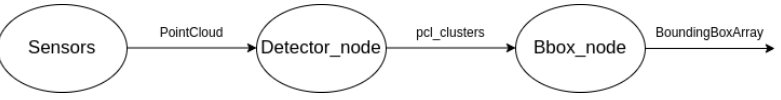
Figure 5. Perception module architecture.